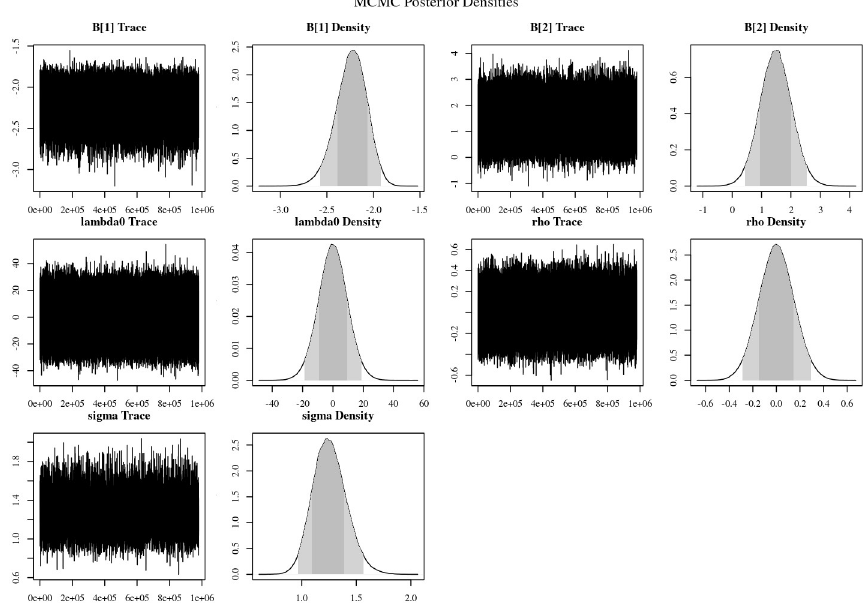
Fig 4. Posterior densities and MCMC trace plots for the Temperature model. The density functions contain two shaded regions: light grey corresponds to the 95% highest density region; and the dark grey corresponds to the 68% highest density region (see S1 File for similar plots corresponding to the other